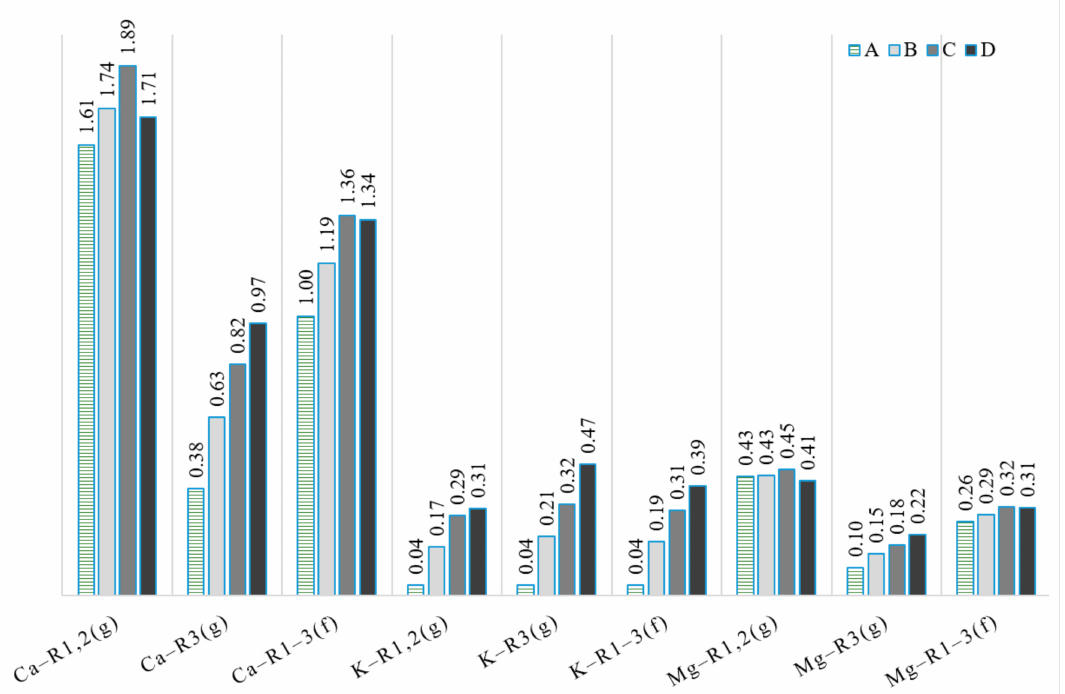
Figure 4. Subtotal content of selected macrocomponents in the substrates and in the soil (in % of dry matter, d.m.); g—greenhouse,